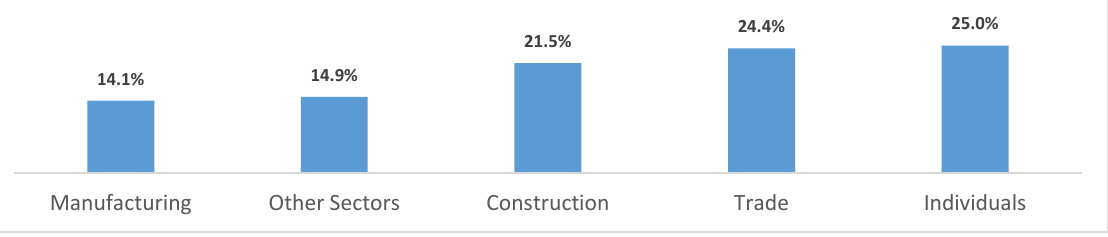
Fig. 2. The Sectoral Distribution of Bank Credit (1992 - 2019)